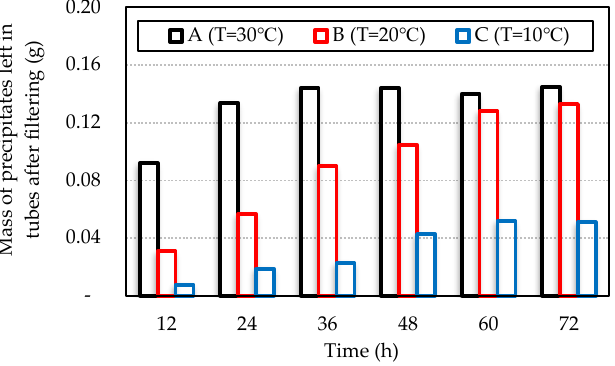
Figure 4. Mass of the precipitates left in tubes after filtering.